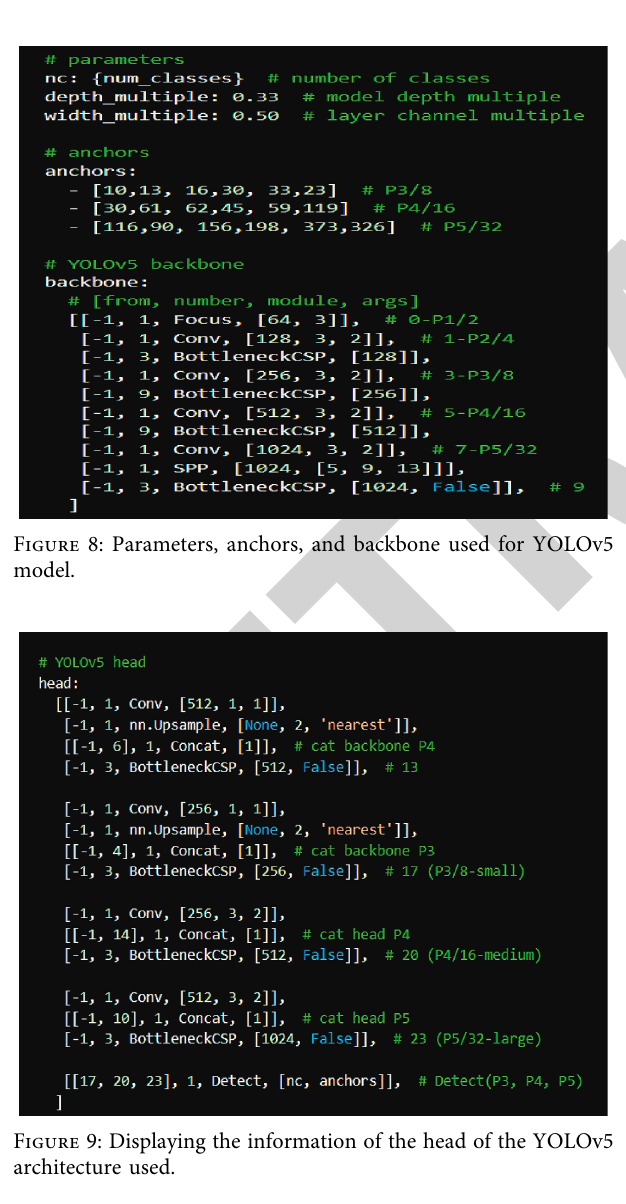
Figure 7: Process of implementing